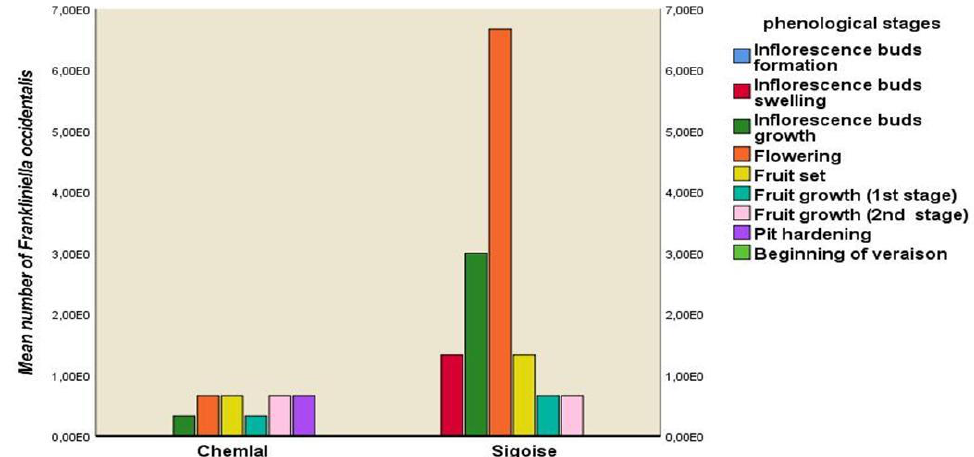
Figure 8. Mean number of F. occidentalis according to olive varieties phenological stages in Batna region.